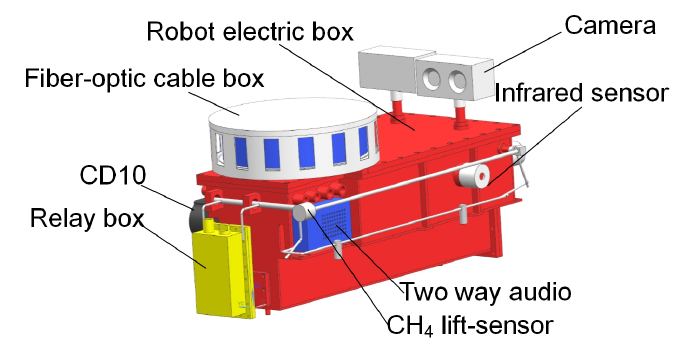
Figure 5. The structure of the robot electric box and fiber-optic cable